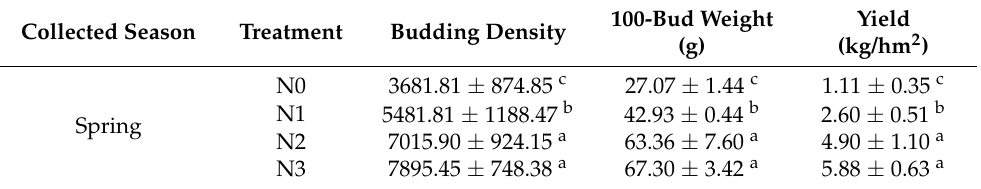
Table 1. Effect of long-term nitrogen application on budding density, 100-bud weight, and yield of spring tea.